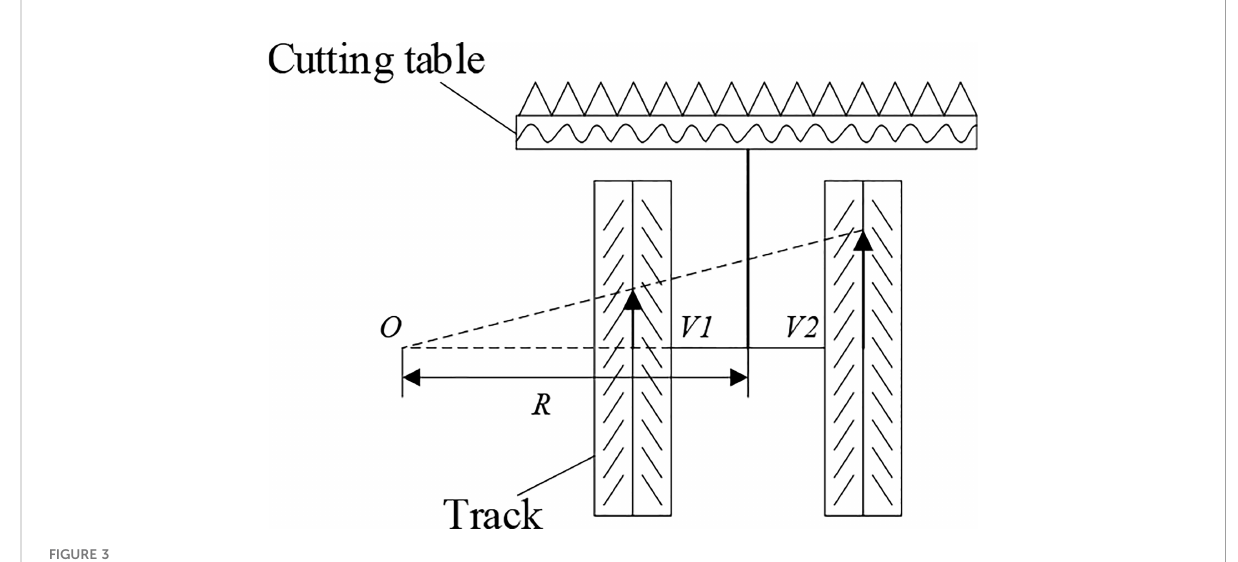
FIGURE 3 Turning radius of tracked